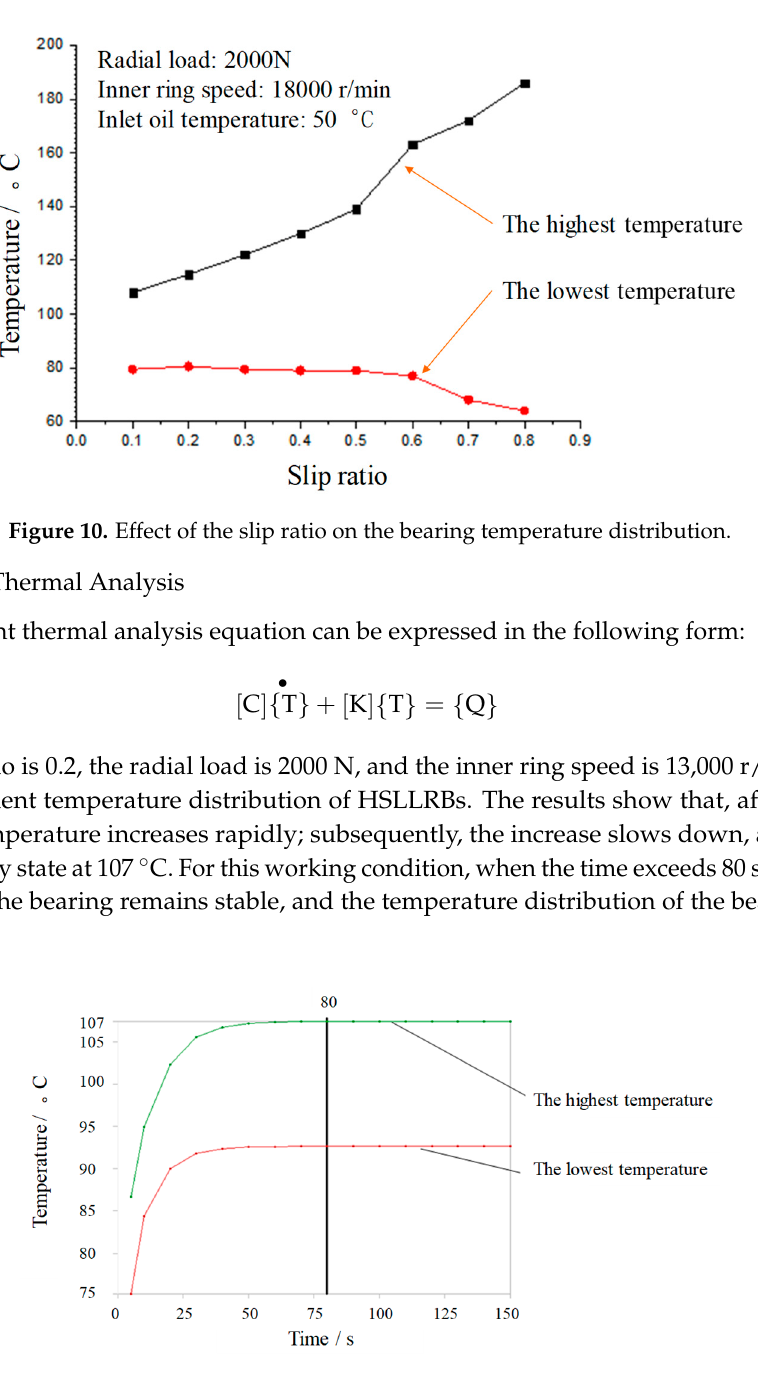
Figure 11. Transient temperature of the bearing.